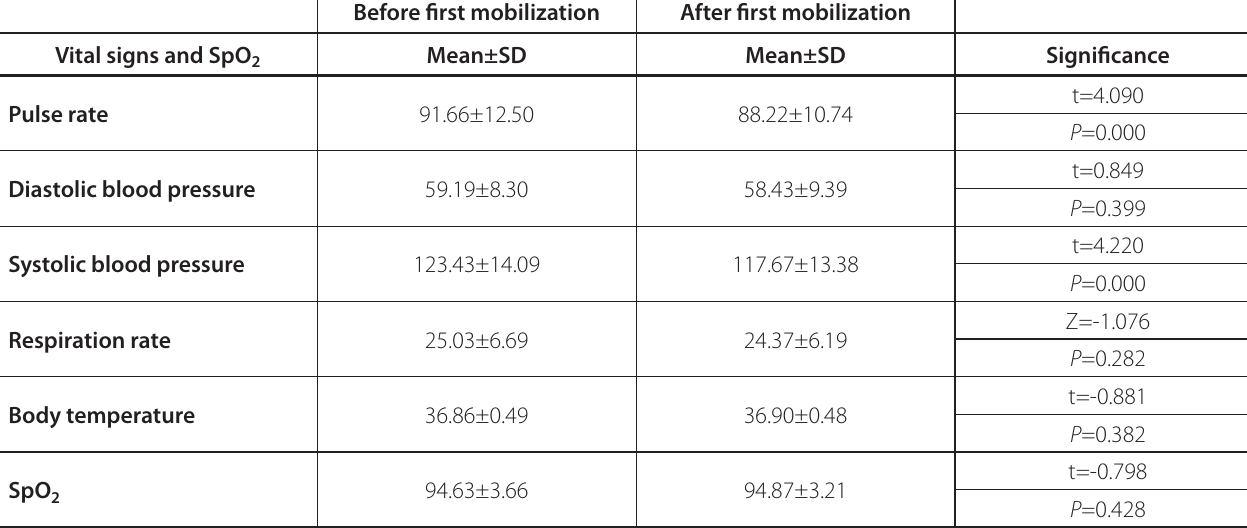
Table 2 . Comparison of vital signs and oxygen saturation in patients before and after first mobilization (n=67).